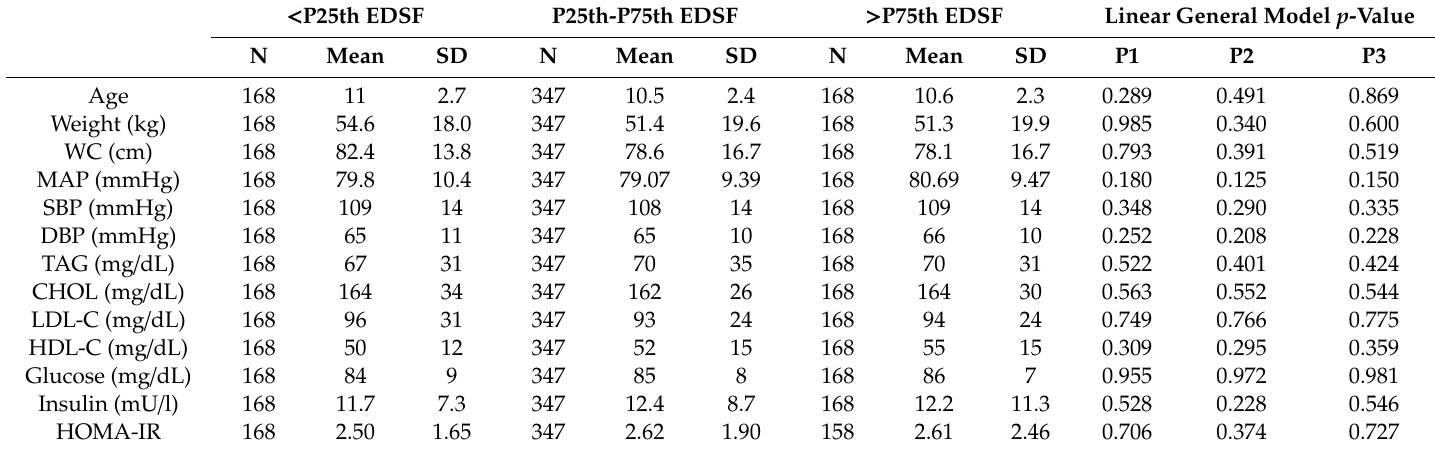
Table 4. Anthropometric and metabolic variables by quartiles of frequency of consumption of energy dense salty